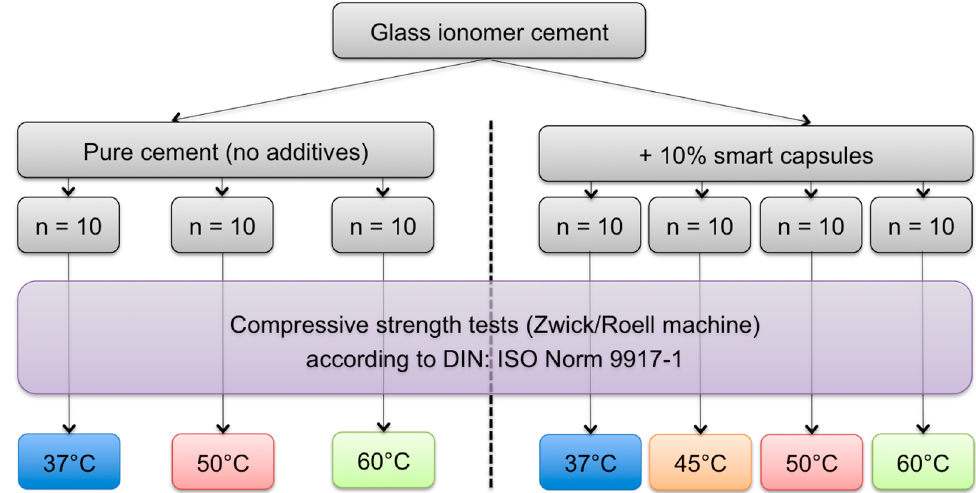
Figure 3. A graph illustrating the different control and test groups subjected to compressive strength tests. A total of 30 test blocks were used for each group with temperatures 37 °C, 50 °C and 60 °C. Ten extra blocks were compressed under 45 °C for the test group to investigate if there was a decrease in compressive strength in temperatures lower than 50 °C.